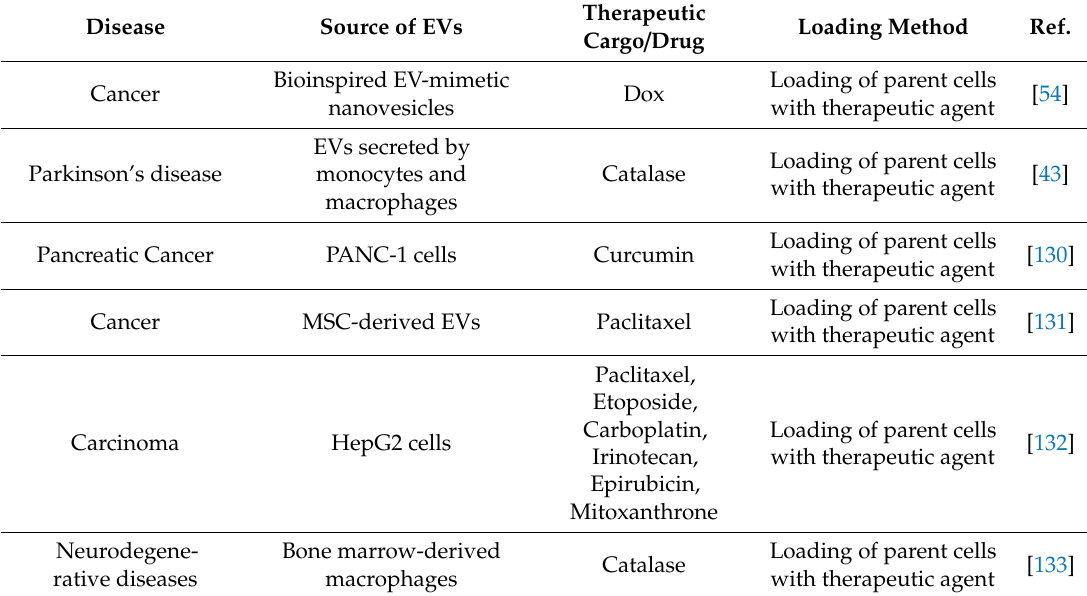
Table 2. Summary of preclinical investigations with EV-based drug formulations obtained via exogenous